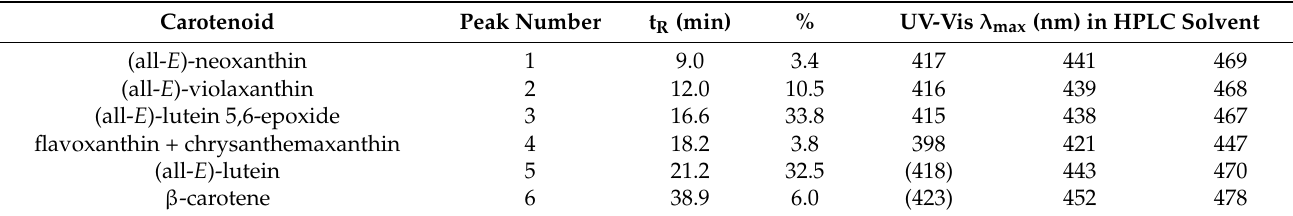
Figure 2. The HPLC chromatogram of the crystallized extract of Meliloti herba. Detection at 450 nm; other conditions in the Material and Methods section. For peak numbers see Table 2. Table 2. The carotenoid composition of the crystallized extract of Meliloti